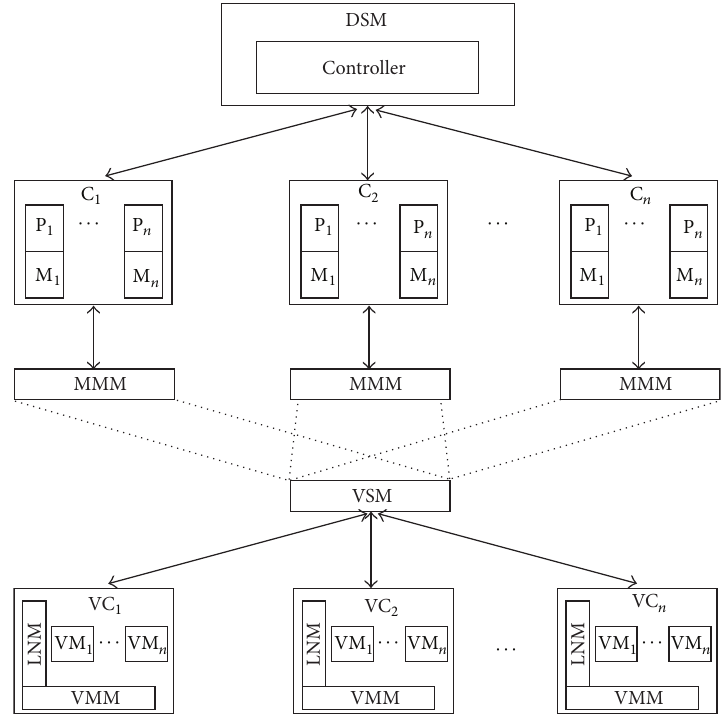
Figure 4: Virtual distributed shared memory cluster architecture